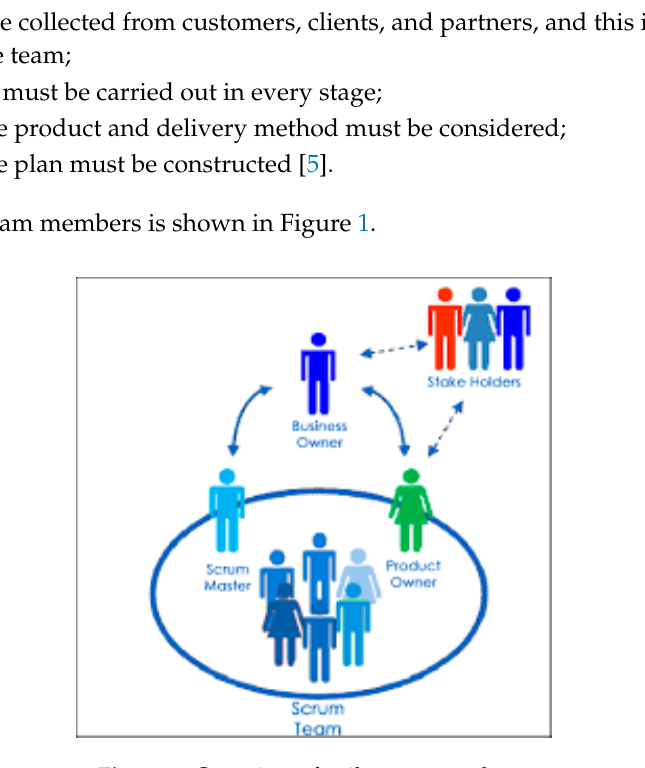
Figure 1. Overview of agile team members.